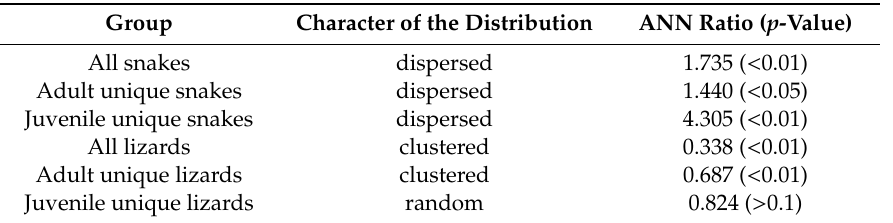
Table 1. Average Nearest Neighbor